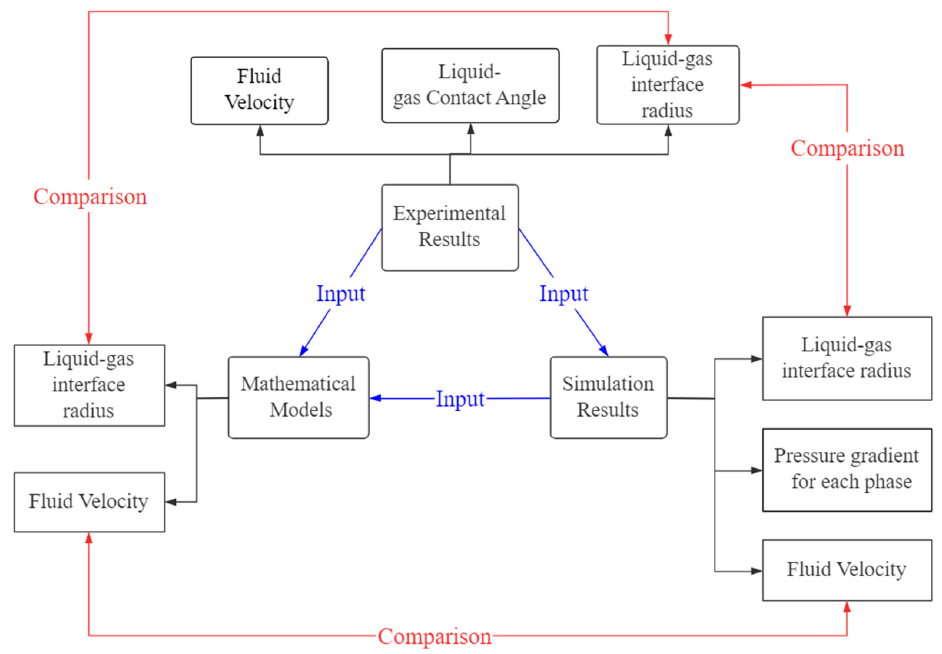
Figure 1. Flow Chart Demonstrating Relationship Between the Three Parts of the Research